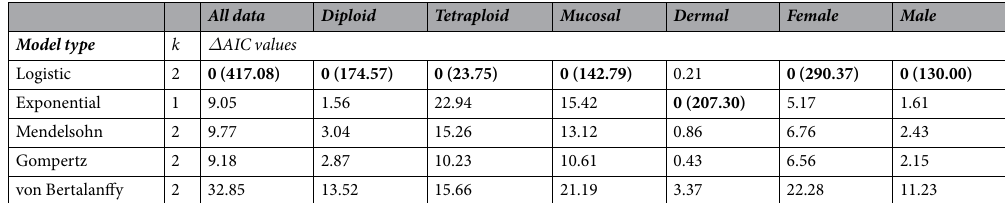
Table 1. Δ AICc values for each maximum likelihood statistical model tested on tumour growth models. AICc values of the best fit model for each tumour characteristic are given in parentheses.